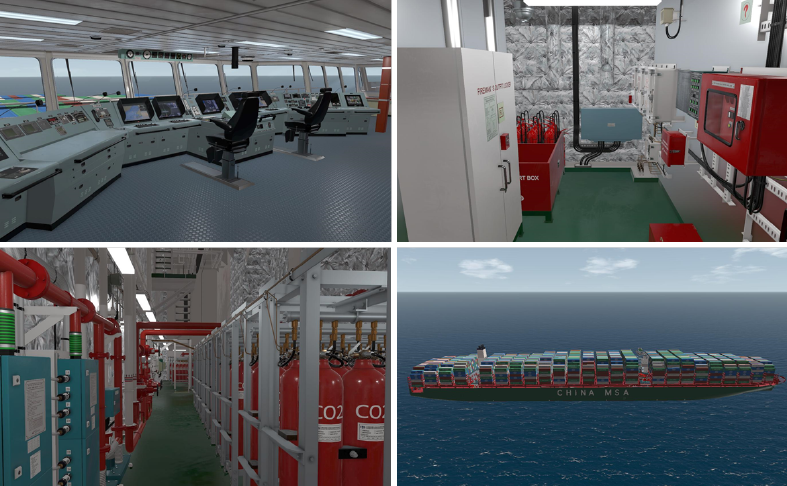
Figure 3. Models rendered in Unity. Left top corner: bridge; right top corner: fire control room; left bottom corner: CO 2 room; right bottom corner: the whole